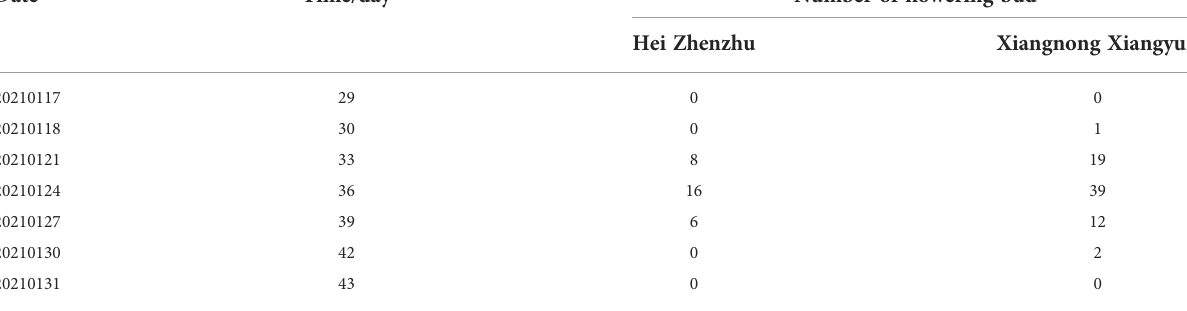
TABLE 3 Flowering number and fl owering time under normothermic (25°C) culture after low-temperature induction.